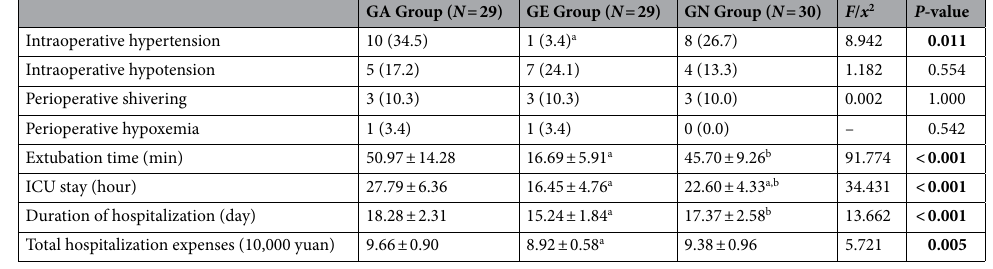
Table 3. Comparison of perioperative adverse events and time efficiency among the three groups. a Compared with the GA group, P < 0.05; b Compared with the GE group, P < 0.05. Intraoperative hypertension was defined as the patient’s blood pressure increased by more than 30% of the basic blood pressure, or the systolic blood pressure was ≥ 140 mmHg and/or the diastolic blood pressure was ≥ 90 mmHg; Intraoperative hypotension was defined as a systolic pressure less than 90 mmHg or reduction greater than 20% of baseline; Perioperative shivering was defined as involuntary body shivering and perioperative hypoxemia was defined as blood oxygen saturation less than 90%. Significant values are in